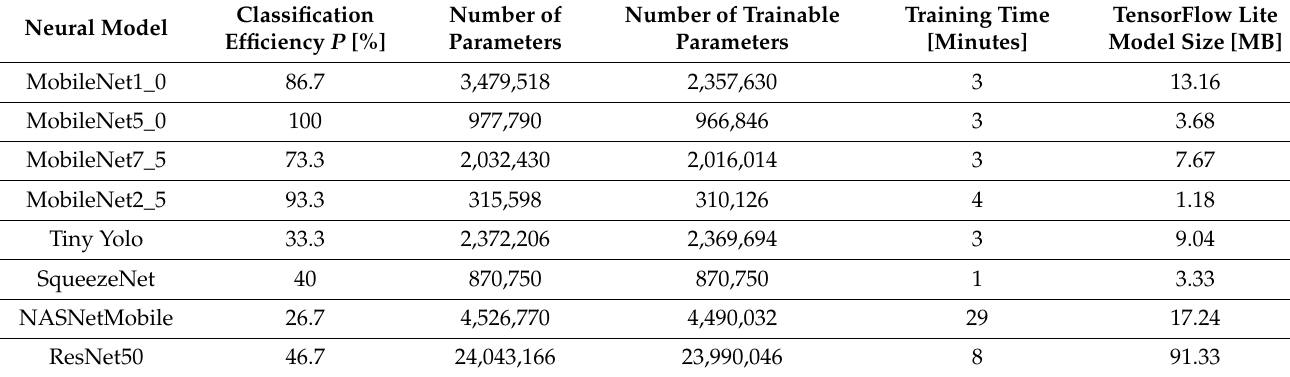
Table 4. Comparison of neural classifiers.